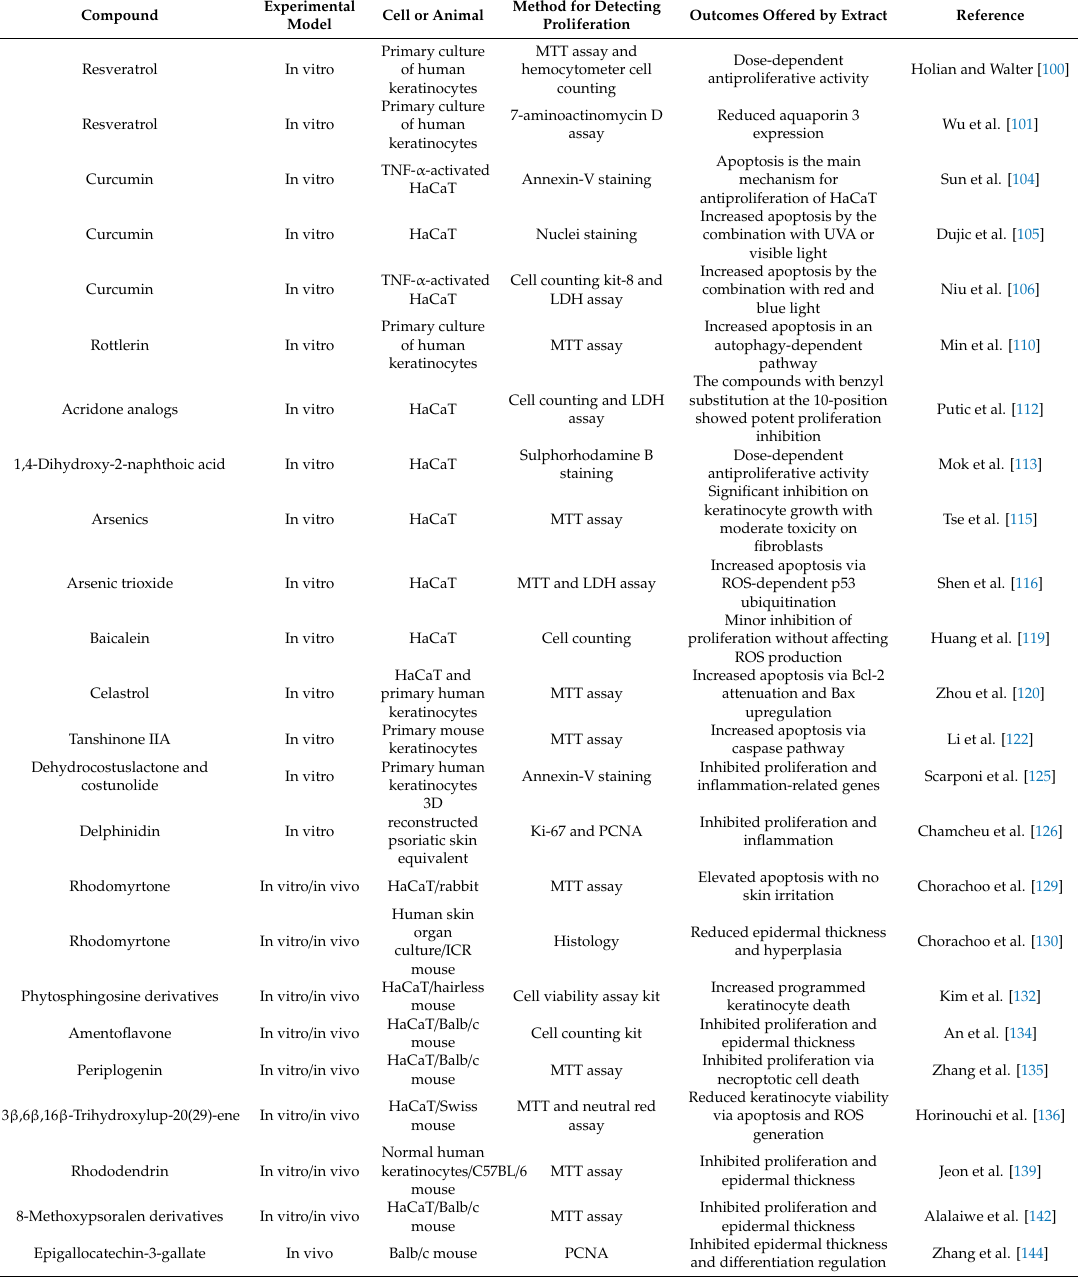
Table 3. Pure compounds derived from the plants for treating hyperproliferation of psoriasis.